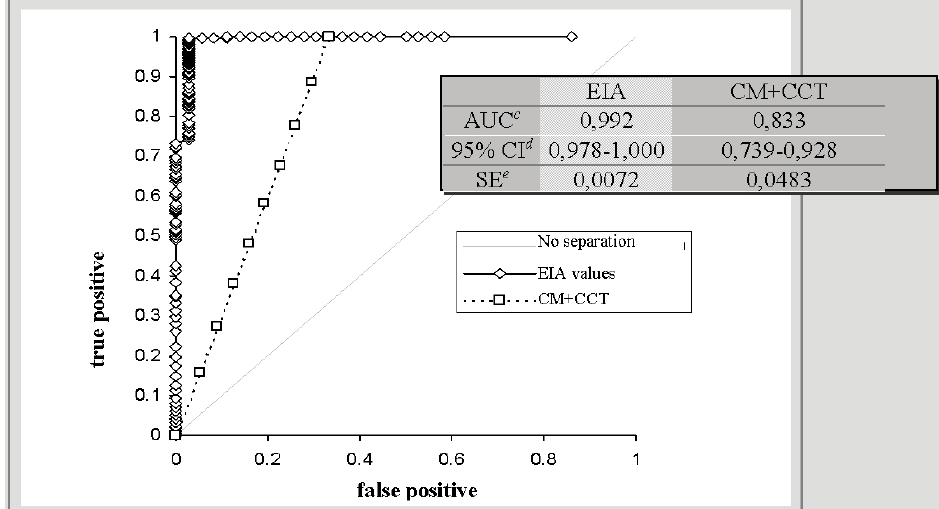
Figure 1. ROC curve: diagnostic characteristics of EIA a method and CM plus CCT of first stool sample related to “golden standard“(N b =577).